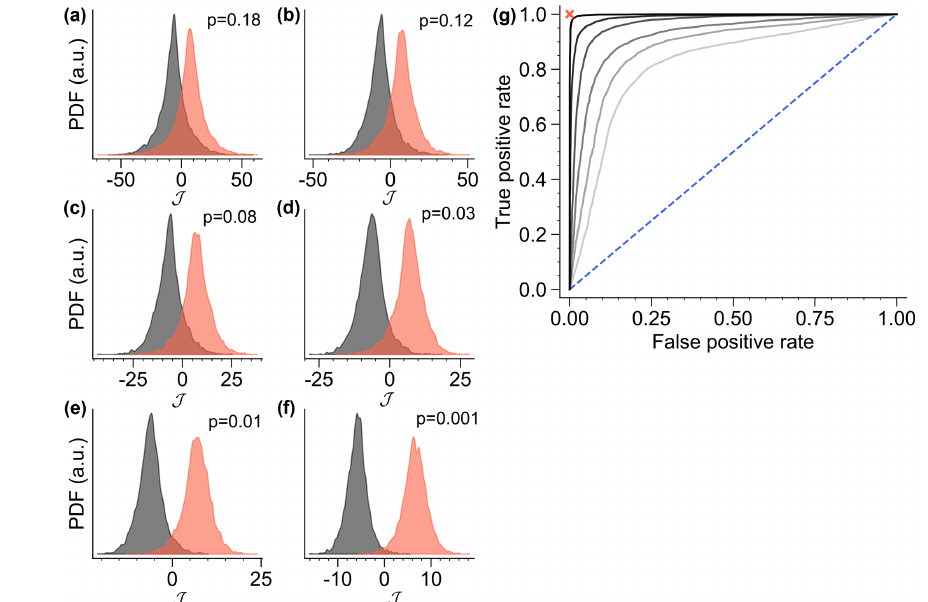
Figure 15. (a–f) Distributions of the early warning indicator J for ensembles of time series from the Stommel model ( σ T = σ S = 0 . 2), estimated around the initial fixed point at η 1 = 2 . 65 (black) and close to the saddle point (orange). For each realization, J is estimated after detrending in a time window that corresponds to the time period that the system spent in the vicinity of the saddle. In increasing order, the panels show results for realizations where these time windows were at least 100, 150, 200, 300, 400, and 600 years long, respectively. (g) Receiver operator characteristic curves for the same time series ensembles, showing the false and true positive rates as the threshold J c is increased from low (top right) to high values (bottom left). The increasing darkness in the gray scale of the curves corresponds to the increasing time window lengths, as above. The diagonal dashed line indicates the performance of a pure chance classifier. The red cross indicates a perfect